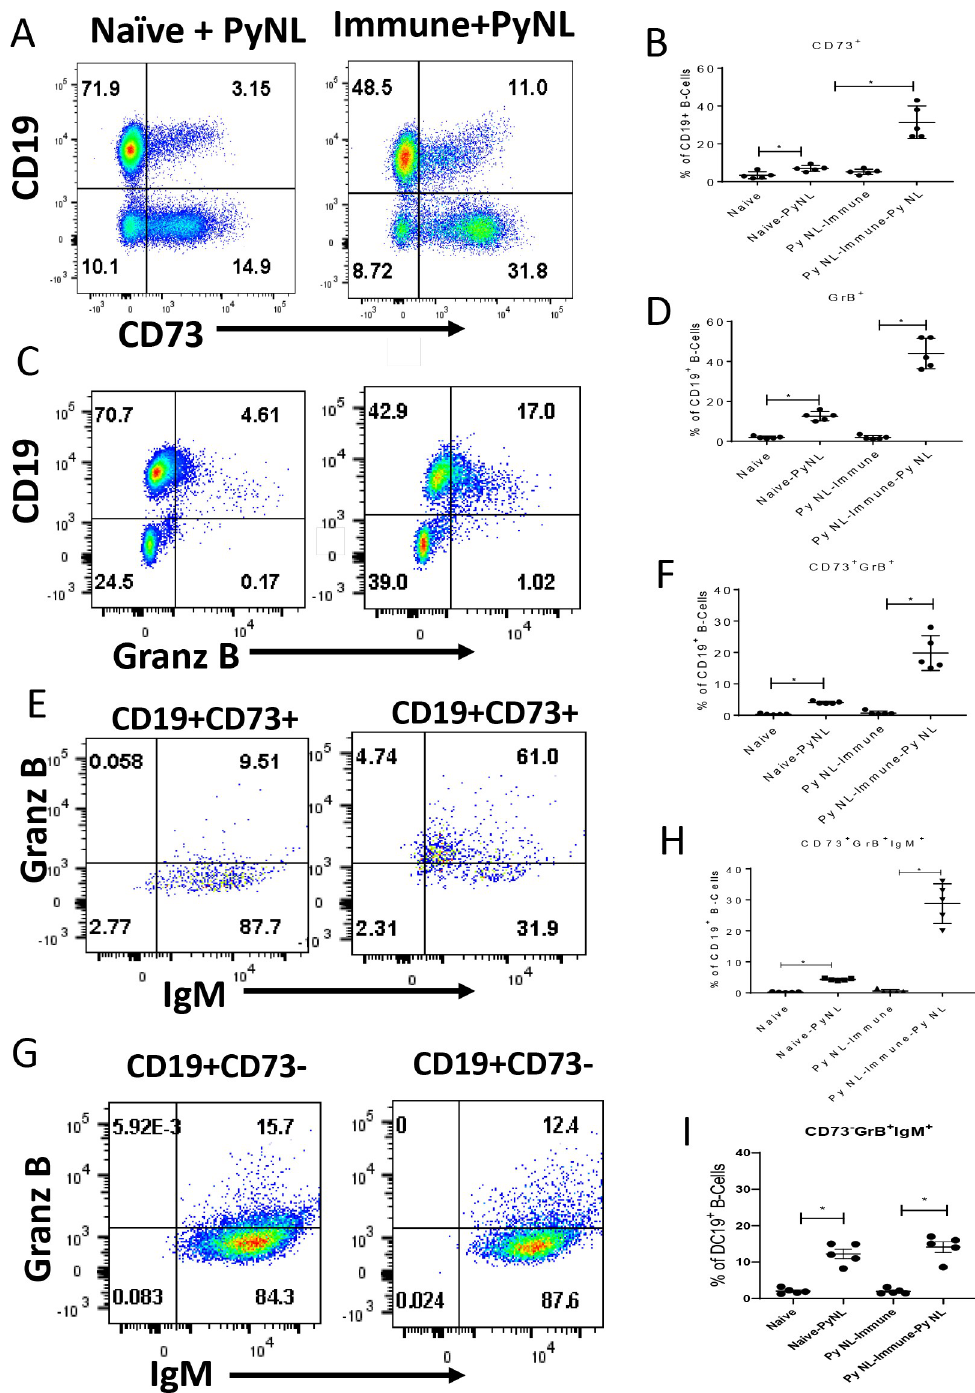
Fig 6. Comparison by flow cytometry of CD19 + B cell frequencies expressing CD73, IgM or Granzyme B (GrB) following an in vitro PyNL infection. Splenic CD19 + B cells were recovered from noninfected mice (naive) or at 4 months post-PyNL clearance (PyNL Immune mice). Five million spleen cells were co-cultured with 5 x 10 6 PyNL iRBC (Naive-PyNL; PyNL Immune-PyNL) or without PyNL iRBC (Naive; PyNL Immune). Representative flow cytometry dot plots from two independent experiments show frequencies of different B cell subsets from stimulated Na ï ve (left column) or Immune splenocytes (right column) (A, C), or after gating on CD19 + CD73 + (E), or CD19 + CD73 - cells (G). Frequencies of B cell subsets shown in B, D, F, H and I are expressed as the percentage of CD19 + cells and, thus, were obtained after gating on CD19 + B cells as shown on the y-axis (n = 5 mice per group). Mann-Whitney test was used for statistical evaluation. � p < 0.05; n = 5 mice per